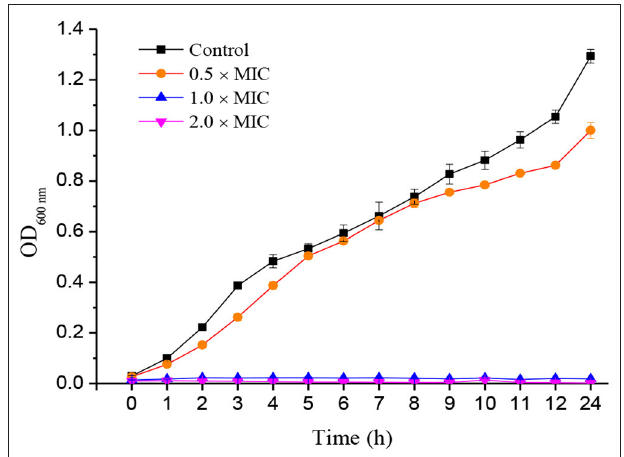
FIGURE 4 | Growth curves of Staphylococcus aureus treated by compound 1